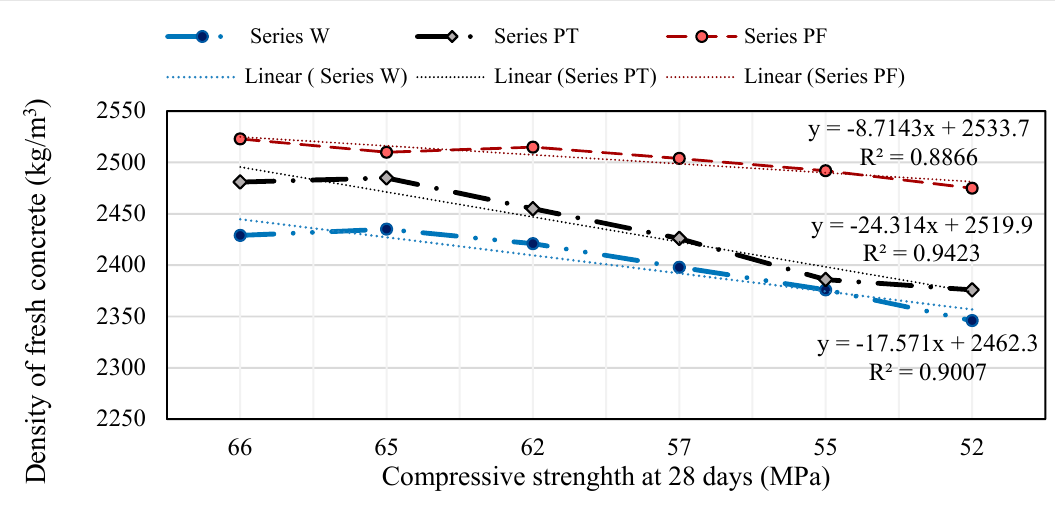
Figure 10. Density of fresh concrete versus f cm at 28 days.